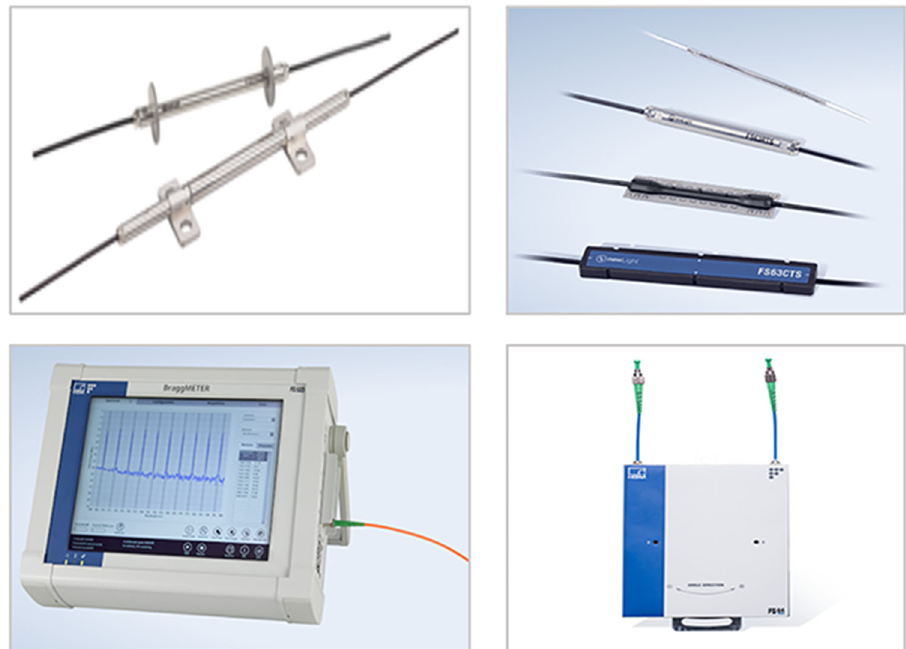
Figure 7. Several commercial FBG sensing elements and units [103,104].